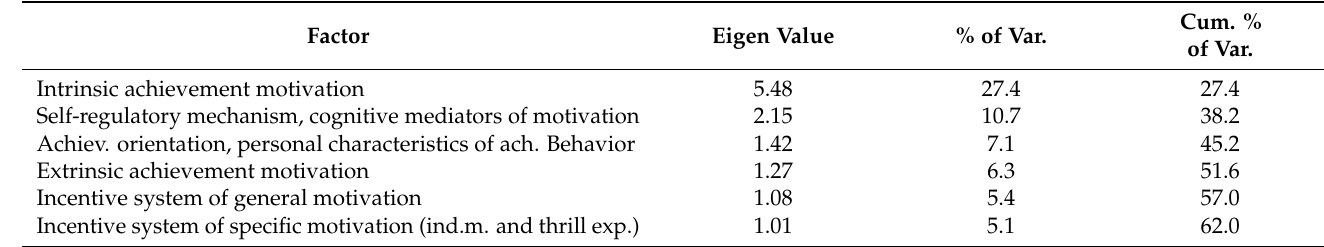
Table 5. Factor analysis of reduced set of motivation variables (PC analysis, varimax rotation). Factor Eigen Value % of Var. Factor of